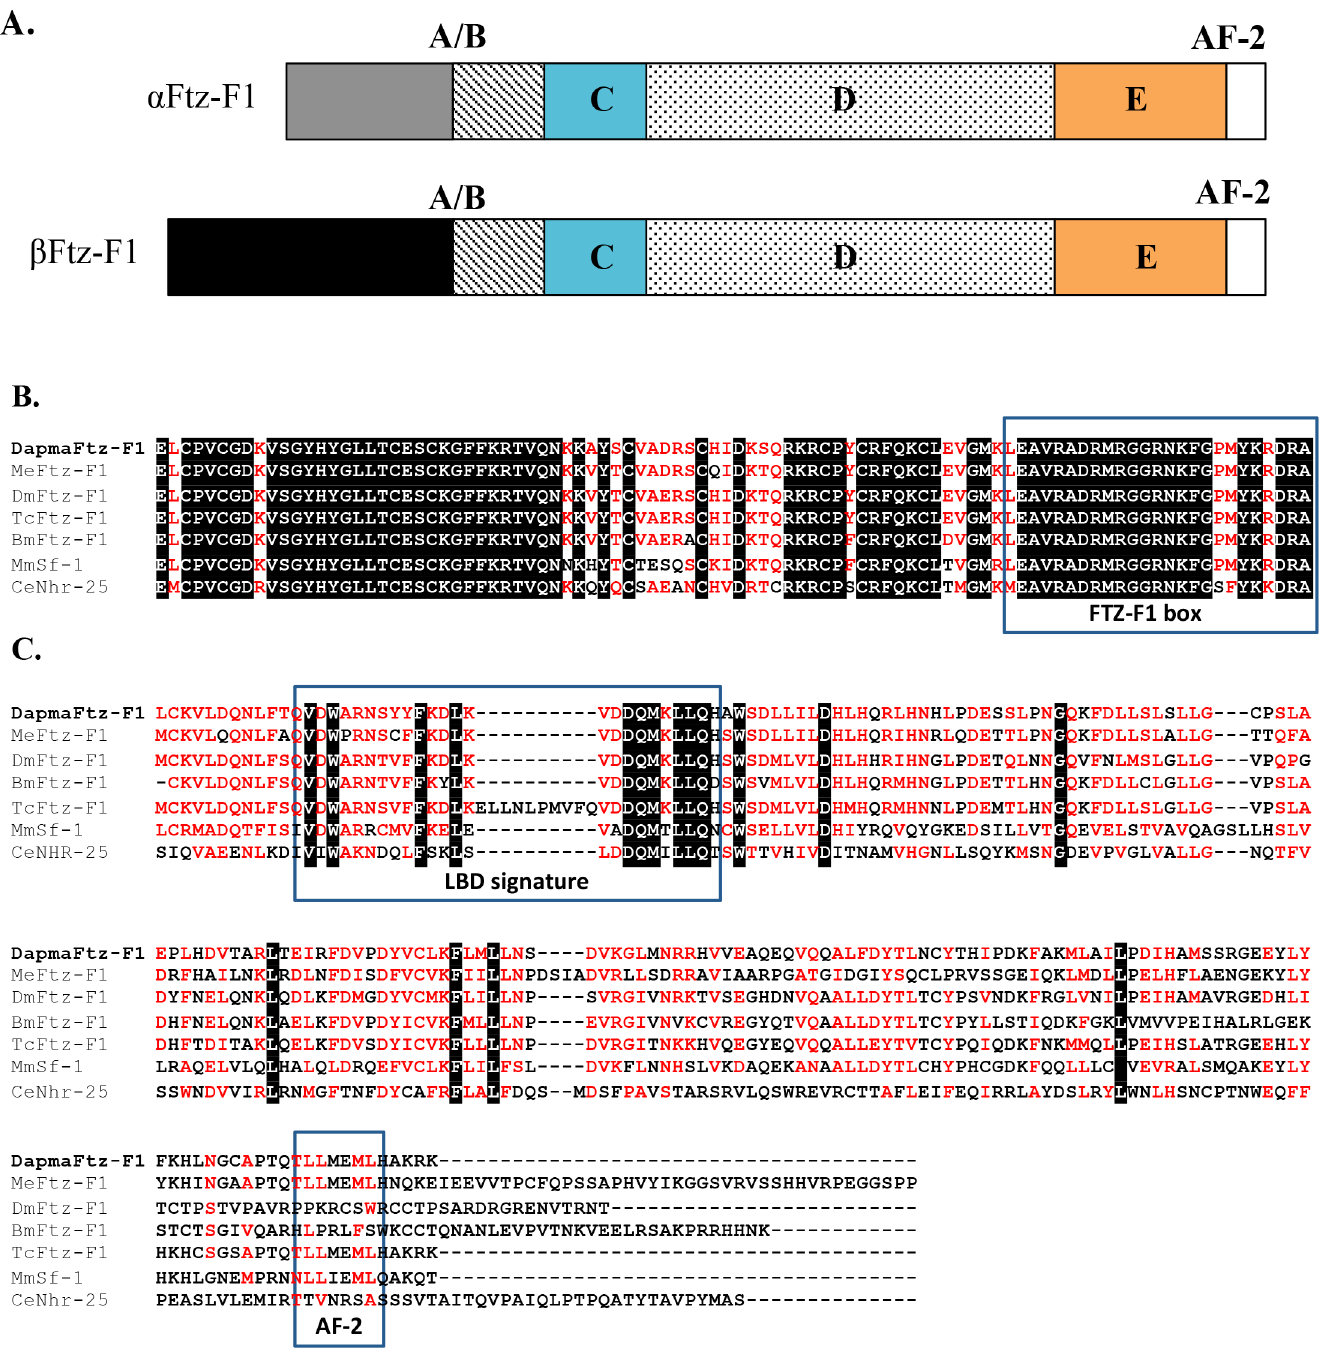
Fig 2. Evolutionary conserved domains of D . magna Ftz-F1. (A) Schematic diagram of the Ftz-F1 regions that are divided into A/B, C, D and E regions. (B) Alignment of the C region and the Ftz-F1 box (boxed), and (C) alignment of the E region showing the LBD signature domain (boxed) and AF-2 motif (boxed). Identical amino acids are shaded in black whereas amino acids with similar characteristics are colored in red. MeFtz-F1 is the Me . ensis (shrimp) protein; DmFtz-F1 is the Dr . melanogaster (fruit fly) protein; BmFtz-F1 is the B . mori (silkworm) protein; and TcFtz-F1 is the T . castaneum (beetle) protein. MmSf-1 is the steroidogenic factor-1 of Mu . musculus (mouse); and CeNhr-25 is the nuclear hormone receptor-25 of C . elegans (roundworm).